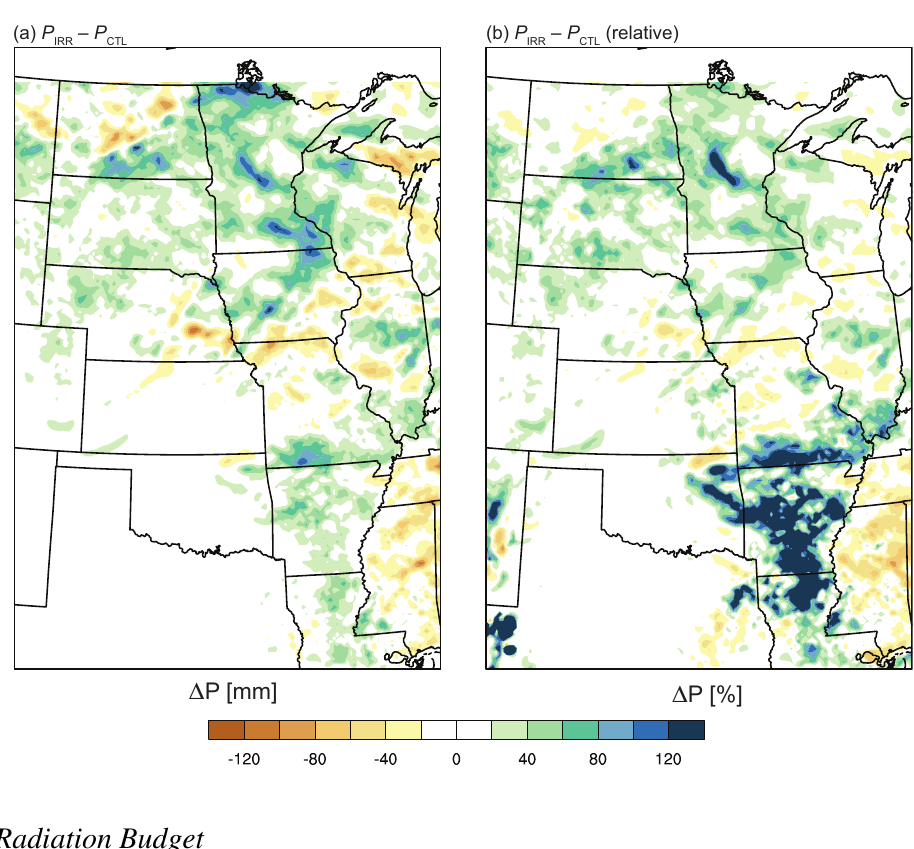
Absolute ( a ) and relative ( b ) difference between the fields in Figure 2a,b